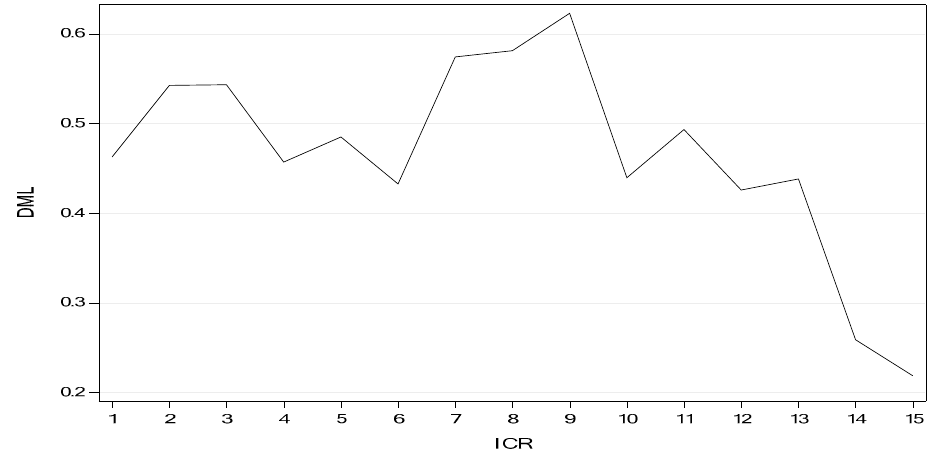
Figure 2. Longer debt maturity and individual credit rating.